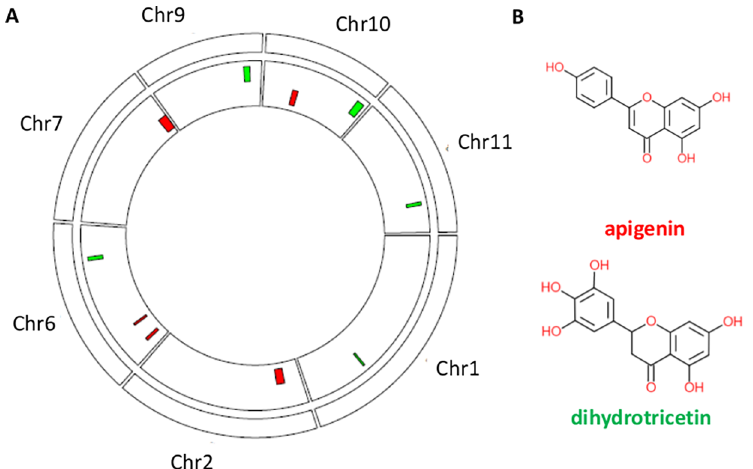
Fig 4. Metabolite traits with different QTL regions are associated with the same two MF terms. (A) QTL regions of metabolitetraits C-pentosyl-apigeninO-rutinoside (red) and 3’,4’,5’-Dihydrotricetin O-hexosyl-O- hexoside(green). It is clear that the QTL regions are completelydifferent. Both traits are however predicted to be connectedto the same MFs. (B) Chemical structures of scaffold of the two metabolites, apigeninand dihydrotricetin. The scaffold of both compoundsis very